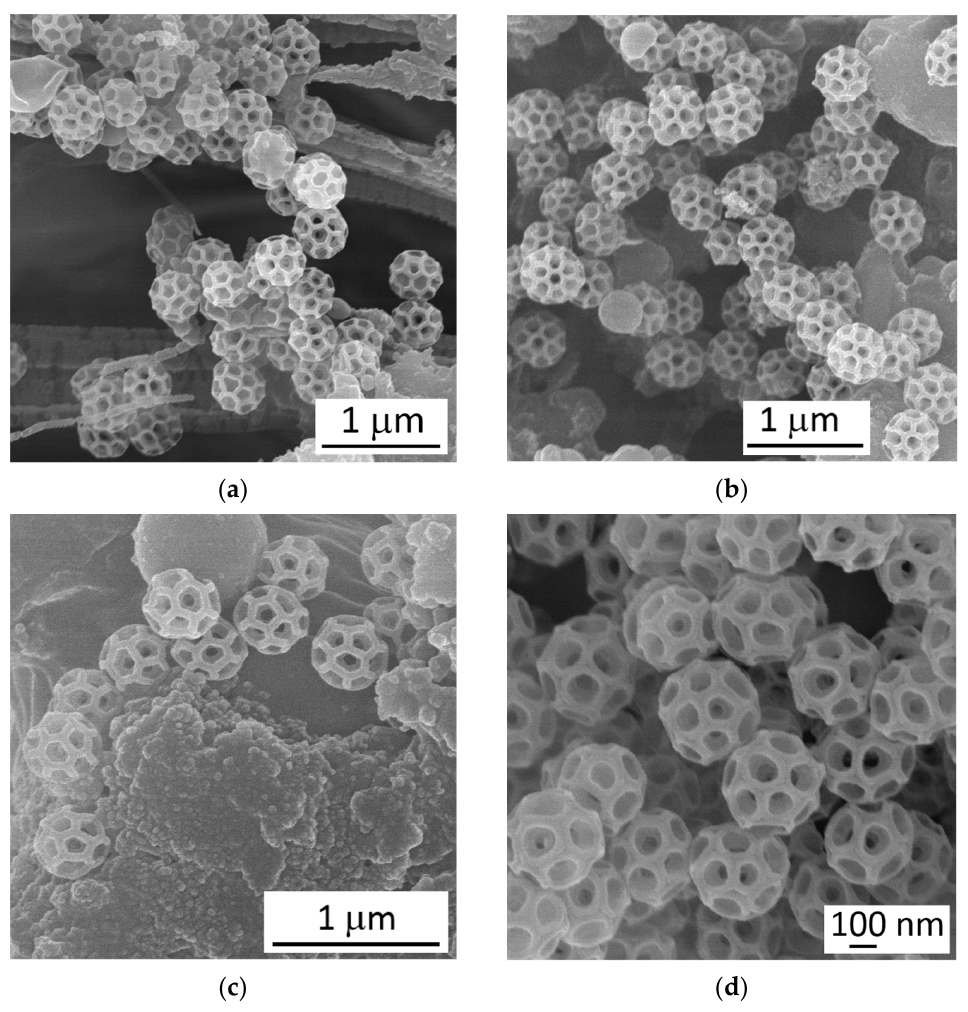
Figure 6. SEM images of brochosome agglomerates found in four aerosol samples in Moscow during summer 2021: ( a )—29 June.; ( b )—14 July.; ( c )—28 July; ( d )—31 July.